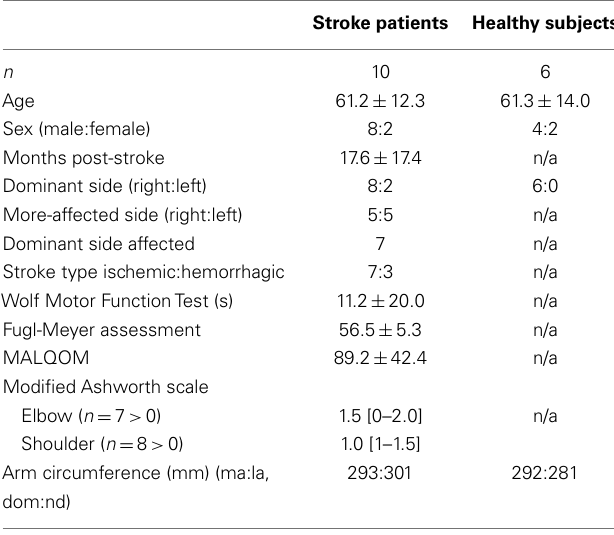
Table 1 | Demographic data and functional scores of patients and healthy subjects